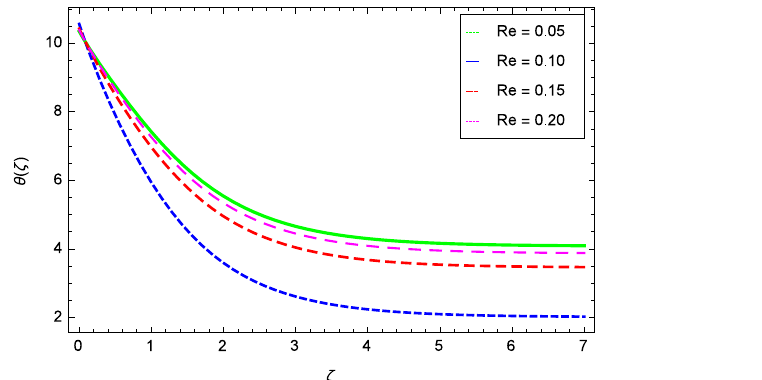
Figure 31. Effect of Re on temperature θ(ζ) .